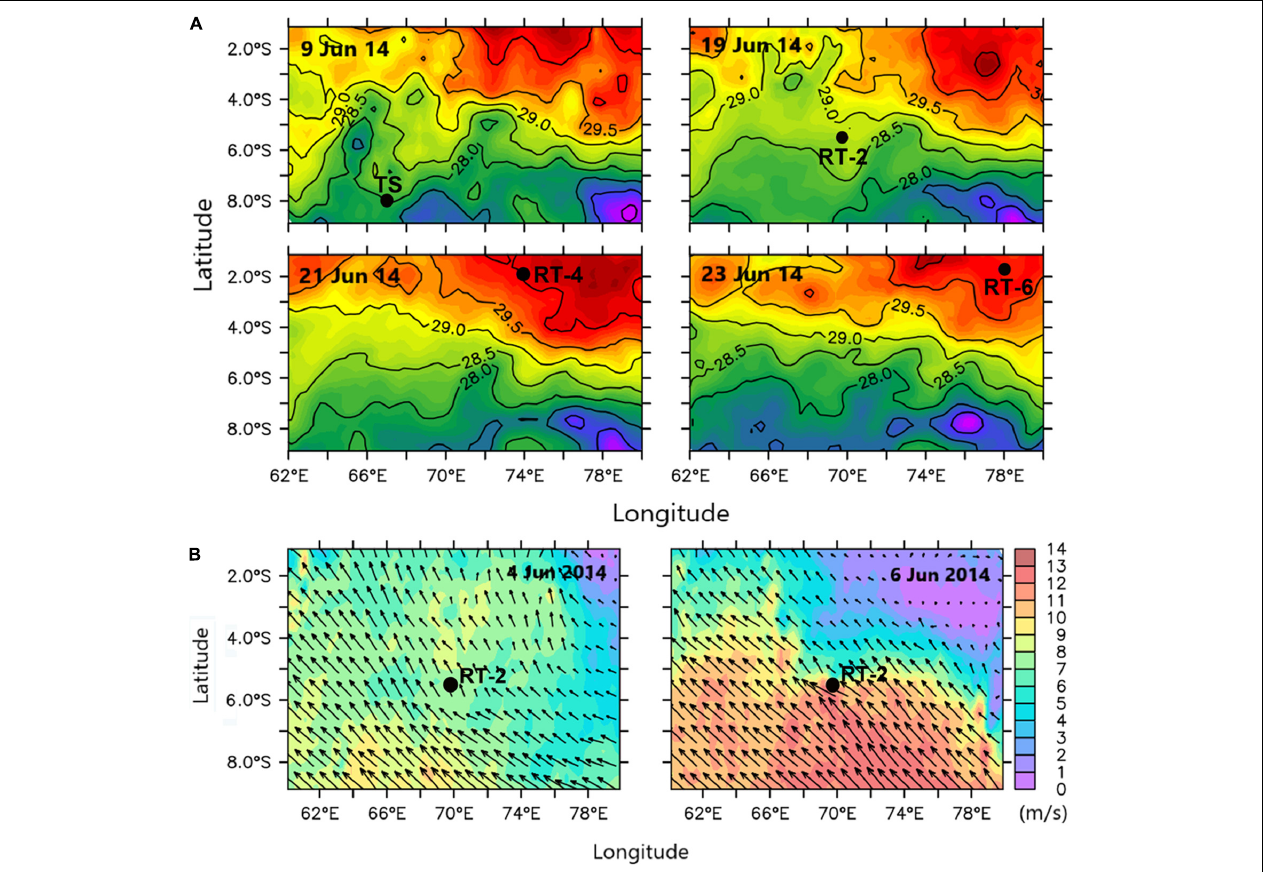
FIGURE 10 | (A) Sea surface temperature (SST) variability during the observation period, and (B) surface wind pattern during 4 and 6 June. Black dots signify station